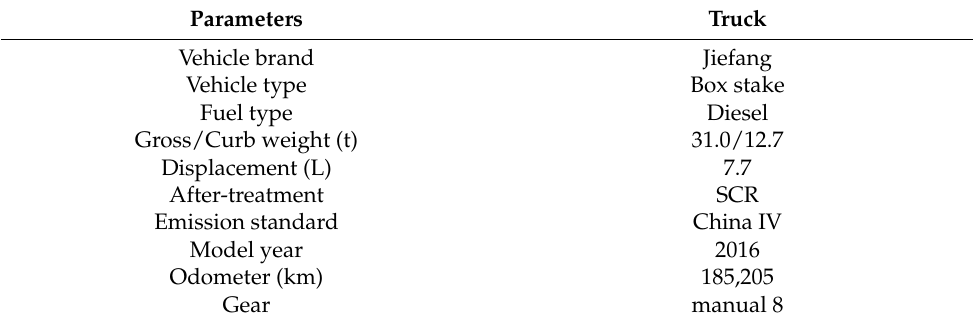
Table 1. Test vehicle specifications.